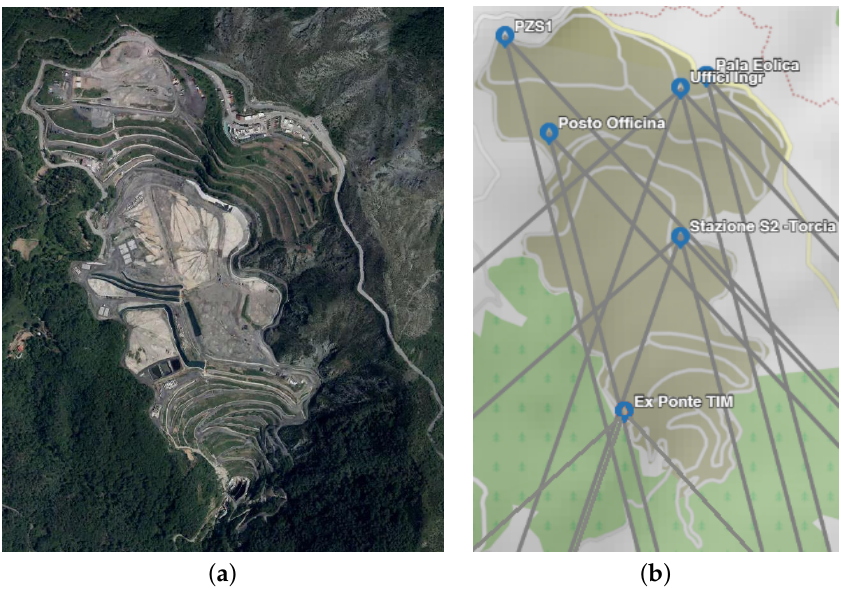
Figure 3. ( a ) Orthophotograph of the Monte Scarpino landfill [28]. ( b ) Map of the geographical loca- tions of the SRS stations in the Monte Scarpino landfill and of the related satellite connection